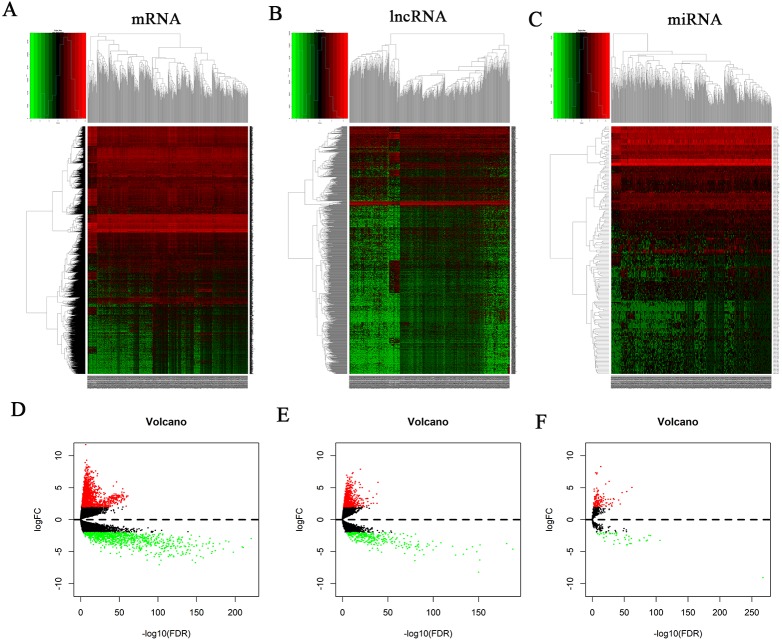
Heatmap and volcano plots of differentially expressed RNAs.(A) Heatmap plots of differentially expressed mRNAs. (B) Heatmap plots of differentially expressed lncRNAs. (C) Heatmap plots of differentially expressed miRNAs. The horizontal axis represents samples. Sample clusters are presented above the horizontal axis. The vertical axis represents RNAs. Red denotes upregulated genes, and green denotes downregulated genes. (D) Volcano plots of differentially expressed mRNAs. (E) Volcano plots of differentially expressed lncRNAs. (F) Volcano plots of differentially expressed miRNAs. The Y-axis denotes the log of FC (base 2) and the X-axis plots the negative log of the false discovery rate (FDR; base 10). Each point represents a gene. Green dots represent downregulated RNAs, red dots represent upregulated RNAs, and black dots represent non-DEGs.